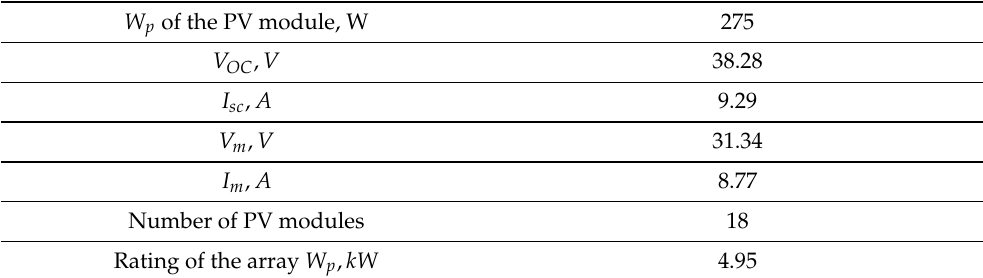
Table 1. Module and array configuration ratings.